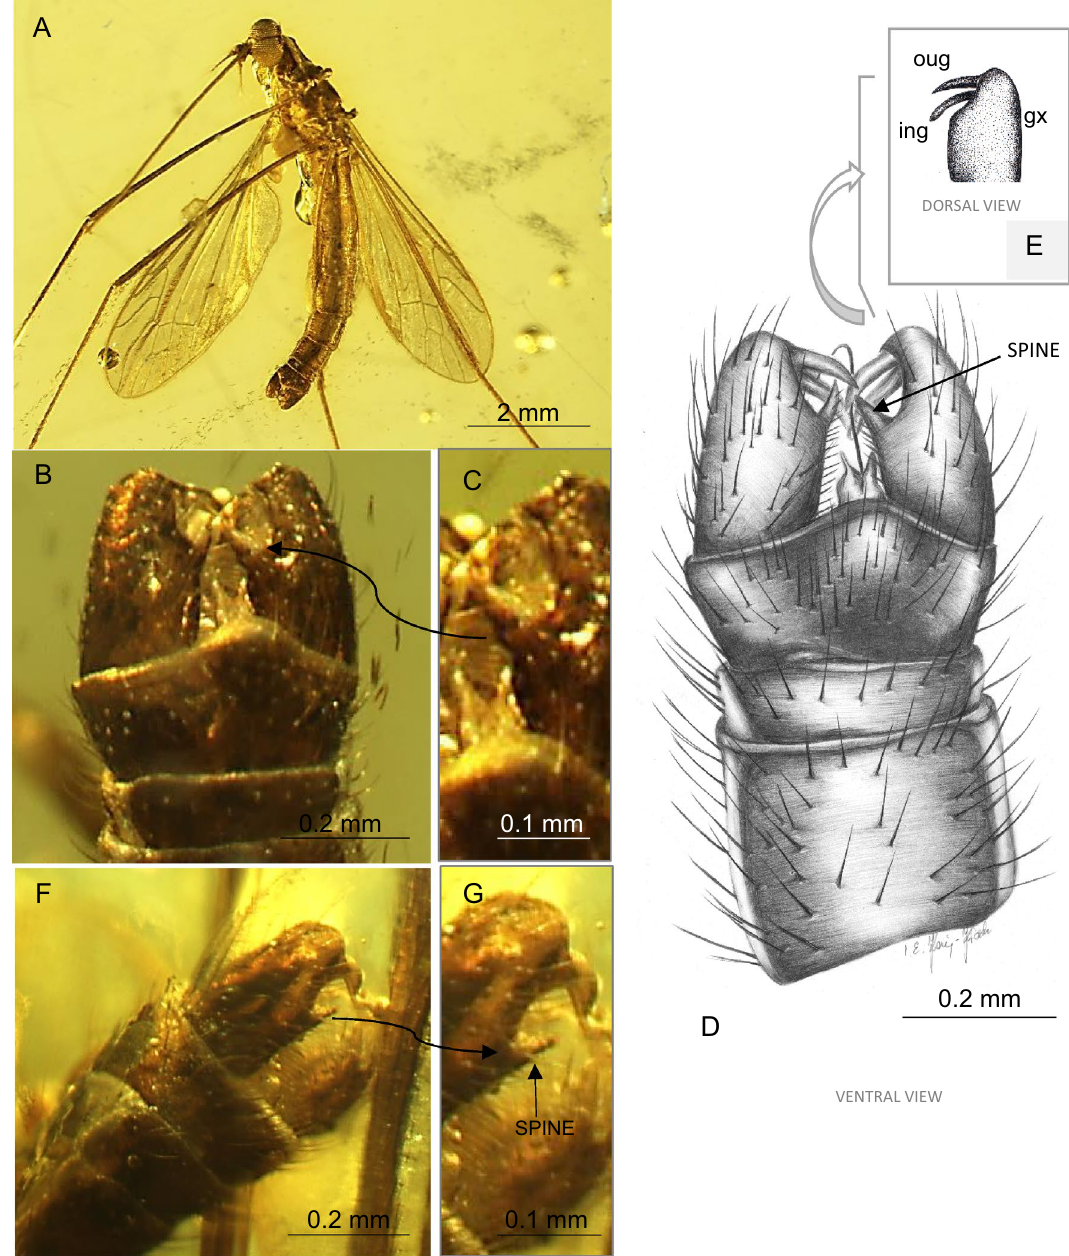
Figure 5. Toxorhina ( Ceratocheilus ) christelius sp. nov. (Limoniidae), inclusion in Baltic amber, ( A – E ) No. MP/4441 (male), holotype, specimen from Institute of Systematics and Evolution of Animals, Polish Academy of Sciences, Kraków, Poland (ISEA PAS): ( A ) body, ventral view; ( B ) photograph of hypopygium with spine on gonocoxite, ventral view; ( C ) enlarged view of spine on gonocoxite; ( D ) drawing of hypopygium—gonocoxite with spine, ventral view (reconstruction); ( E , F ) No. MP/4443 (male), holotype, specimen from Institute of Systematics and Evolution of Animals, Polish Academy of Sciences, Kraków, Poland (ISEA PAS): ( F ) photograph of hypopygium, latero-ventral view; ( G ) photograph of enlarged view of spine on gonocoxite, latero-ventral view. Abbreviations: the black arrow indicates